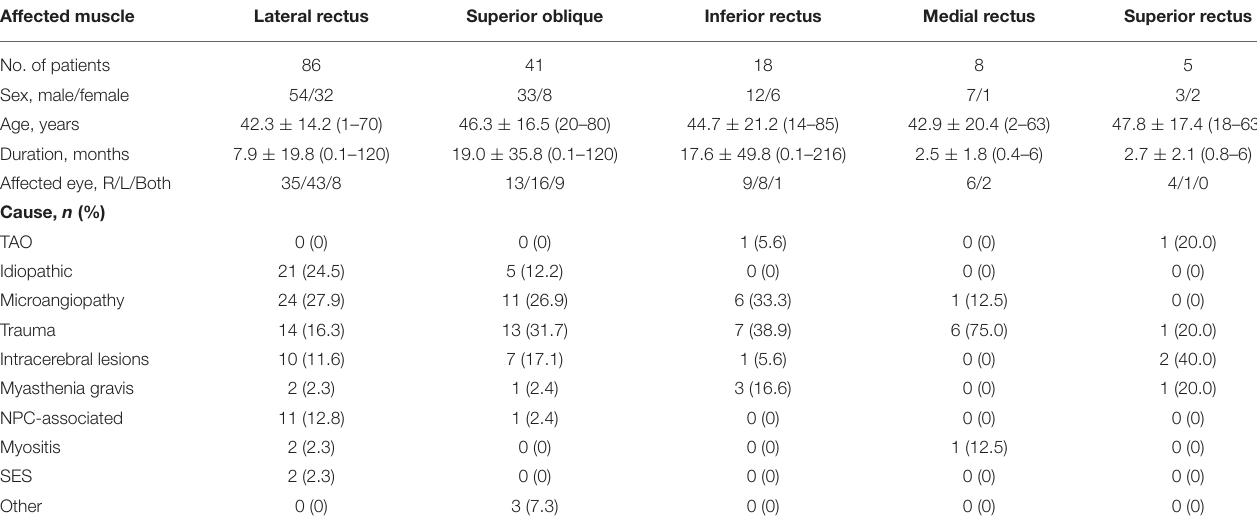
TABLE 2 | Characteristics of patients with paralytic strabismus with sEOM involved. Affected